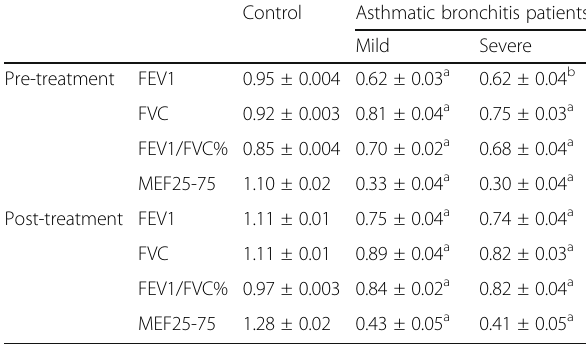
Table 2 Statistical significance of serum pulmonary functions before and after receiving treatment showing the differences between asthmatic bronchitis patients at mild and severe stages as compared to